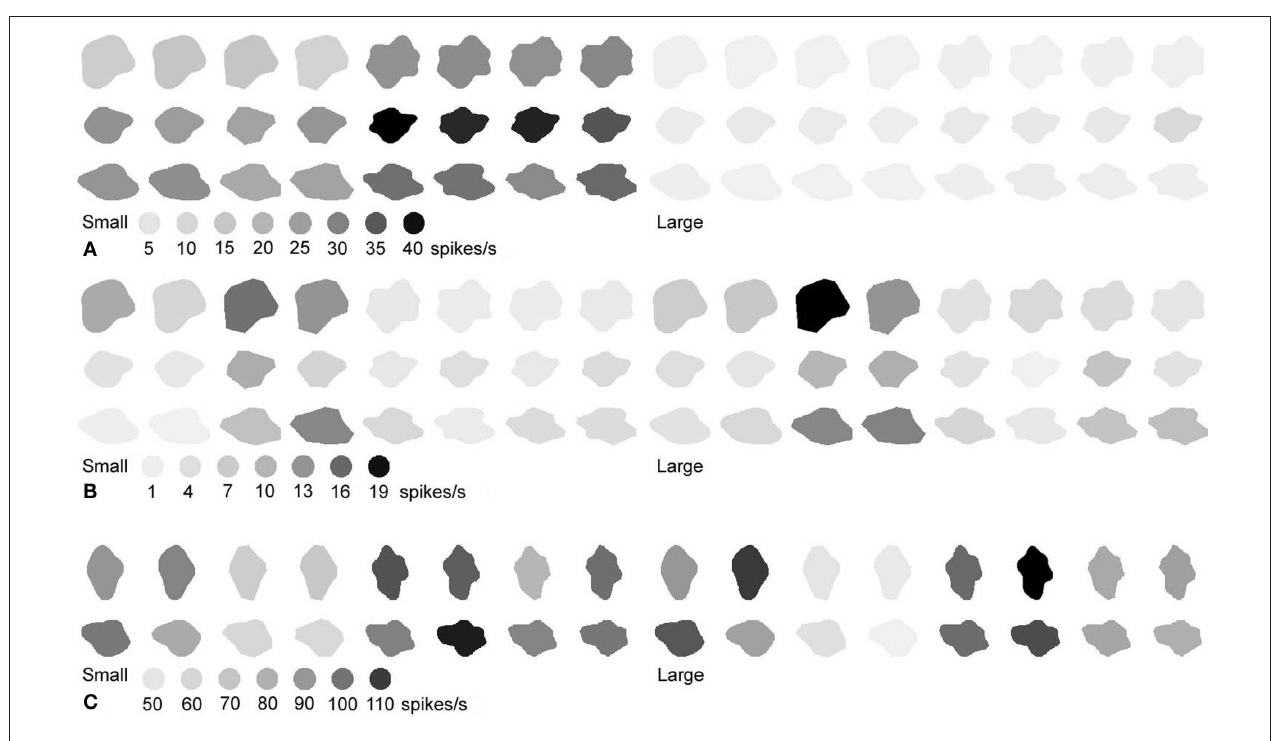
shapes, those to the shapes on the right depict the responses to the large versions of the shapes. (A,B) Show responses to shapes in the first three rows of Figure 2 , while (C) shows responses to the shapes in the last two rows of Figure 2 .